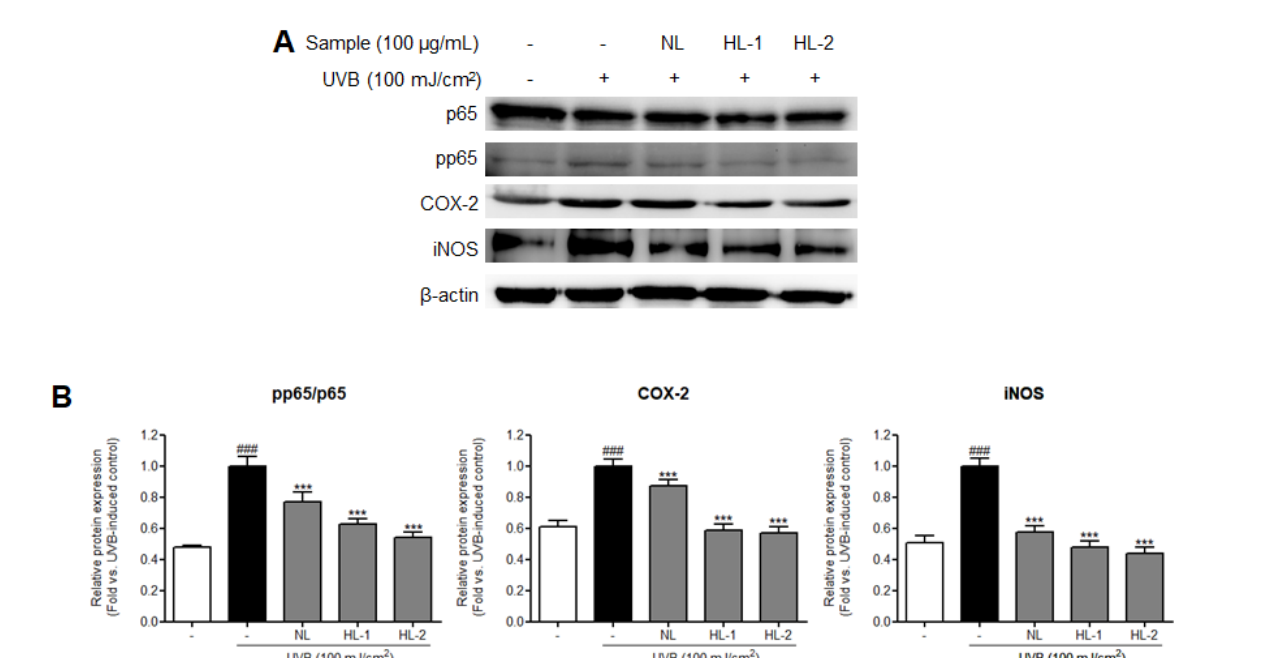
Figure 3. Effect of heat-treated-licorice extracts on the expression of NF- κ B p65 and inflammation-related proteins in UVB- exposed HDFs. Western blotting was performed to assess the expression levels of NF- κ B p65, COX-2, and iNOS. The protein band intensities were normalized to that of β -actin and presented as the mean ± SD ( n = 3). *** p < 0.001 vs. UVB-exposed control; ### p < 0.001 vs. non-treated control. COX-2, cyclooxygenase-2; HDFs, human dermal fibroblasts; HL-1, heat-treated licorice (120 ◦ C); HL-2, heat-treated licorice (130 ◦ C); iNOS, inducible nitric oxide synthase; NL, non-treated licorice; NF- κ B; nuclear factor kappa B; UVB, ultraviolet B.